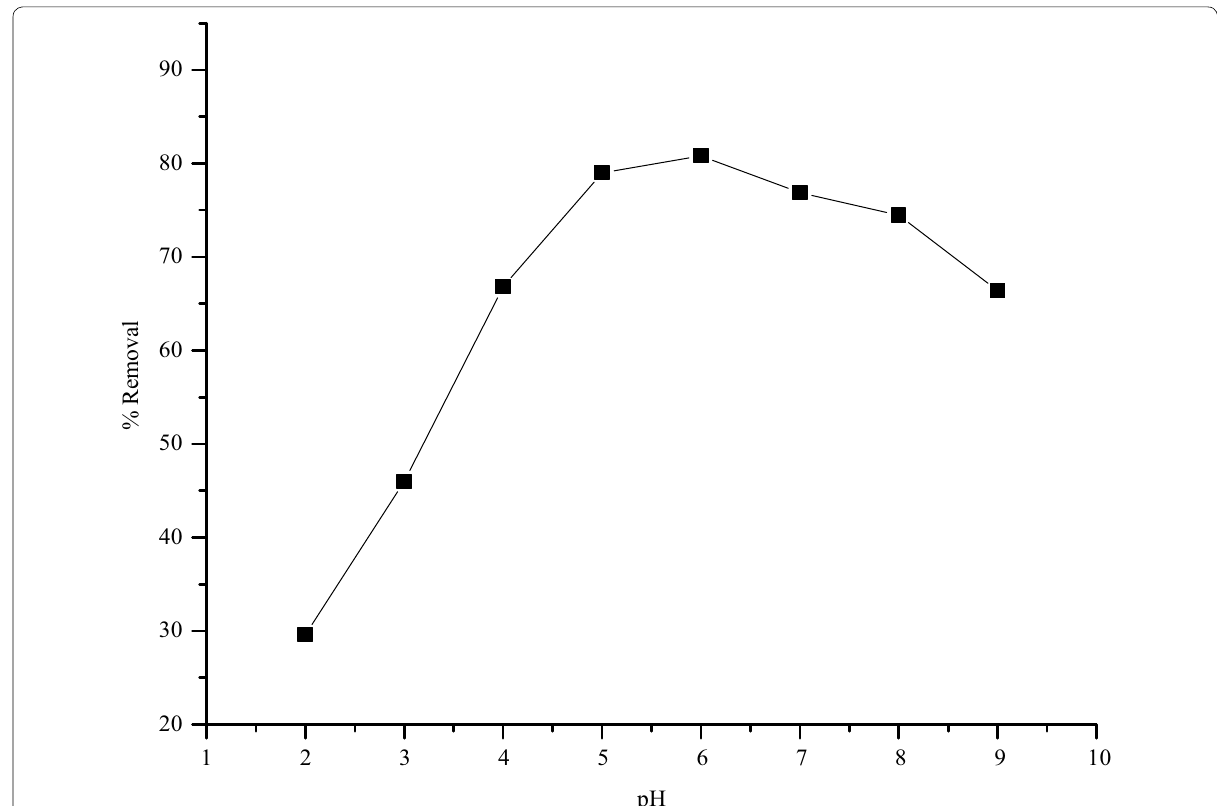
Fig. 4 Effects of pH on the uptake of Cd(II), (initial Cd(II) ions concentration time 120 =